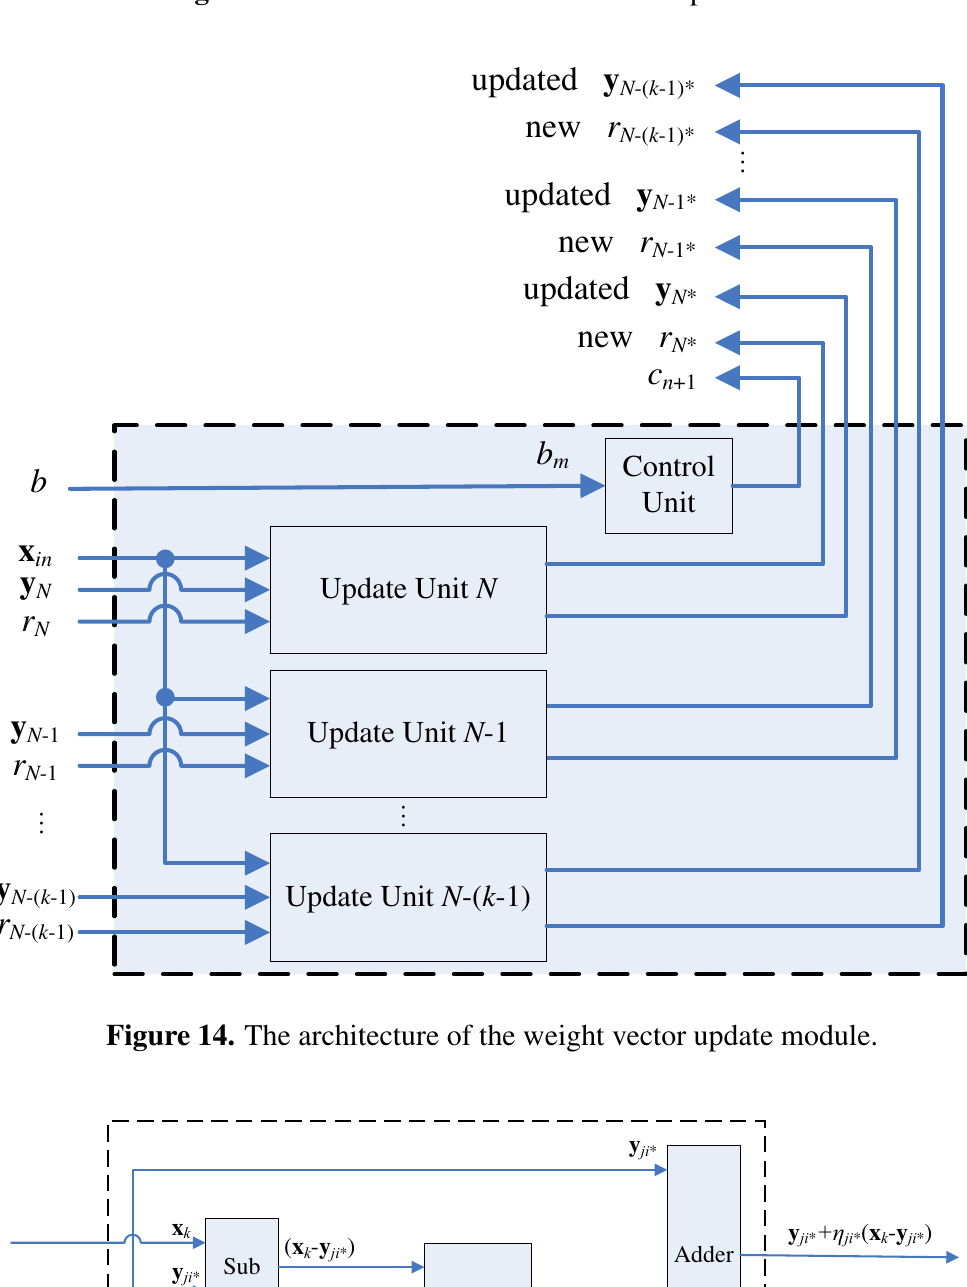
Figure 13. The architecture of the winner update unit.